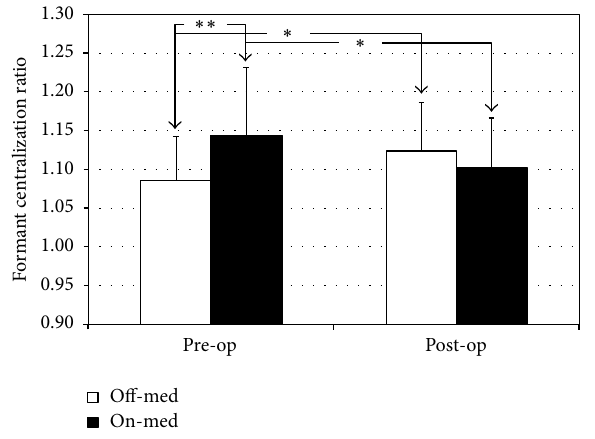
Figure 1: Formant centralization ratio (higher values = reduced articulation) before (Pre-op) and after (Post-op) STN DBS, off- and